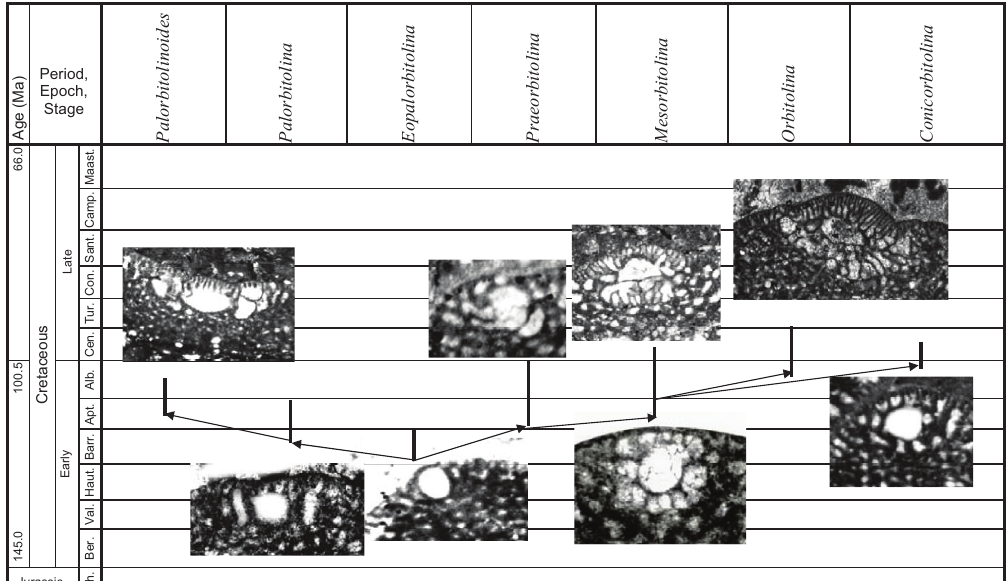
Example of evolutionary Tethyan lineages from morphological Group (ii) to